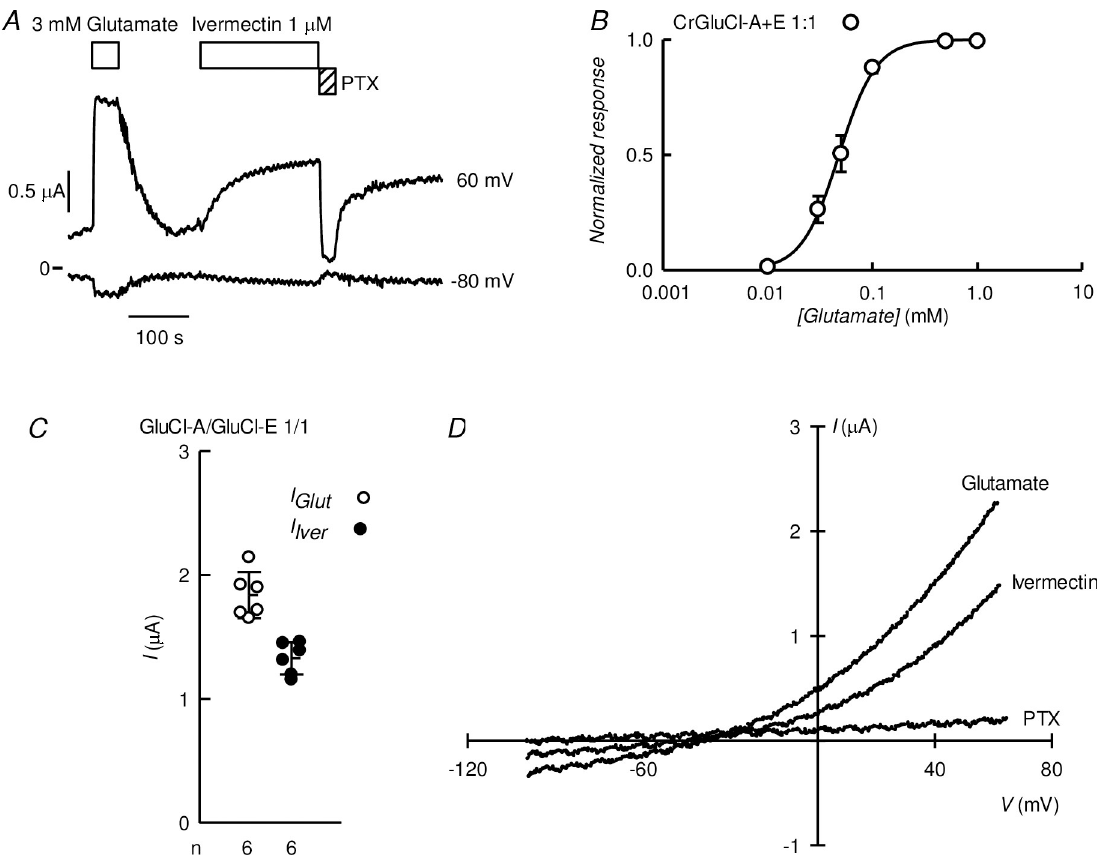
Fig 13. Currents in Xenopus oocytes microinjected with CrGluCl-E and CrGluCl-A cRNAs. A. Currents elicited by 3 mM glutamate or 1 μ M ivermectin in an oocyte after microinjection of 10ng cRNA for each CrGluCl-E and CrGluCl-A. Recording taken at 60 and -80 mV. B. Dose-response relationship of the glutamate-sensitive currents of CrGluCl-EnnCrGluCl-A mixed expression experiments. Data are normalized (mean ± SD, n = 4) to the maximal effect of glutamate. The line is a Hill equation fit. C. Summary of currents elicited by glutamate or ivermectin in oocytes expressing CrGluCl-E and CrGluCl-A together in a 1:1 proportion. Total cRNA injected was always 20 ng. Data points report individual measurements with means ± SDs also shown, n indicated under the abscissa. D. IV relations corresponding to currents after glutamate or ivermectin challenges, as well as during addition of